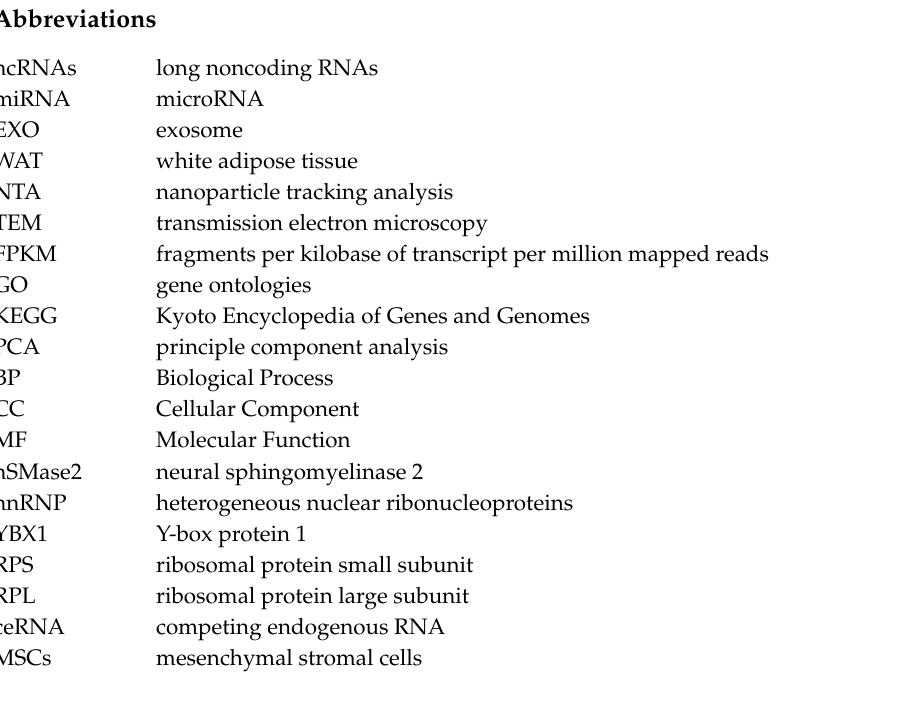
miRNA-mRNA network. Table S14: KEGG pathway result of the miRNA-mRNA network. Table S15: BP result of the lncRNA-miRNA-mRNA network. Table S16: CC result of the the lncRNA-miRNA-mRNA network. Table S17: MF result of the lncRNA-miRNA-mRNA network. Table S18: KEGG result of the lncRNA-miRNA-mRNA